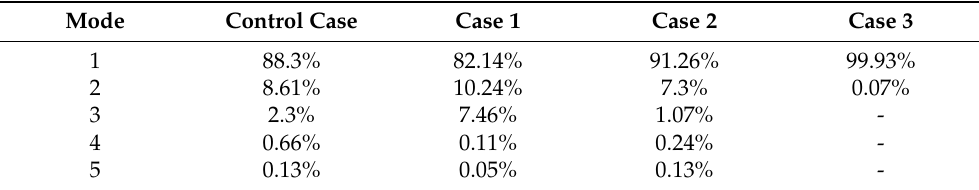
Table 2. Effective modal masses, as percentages of the total